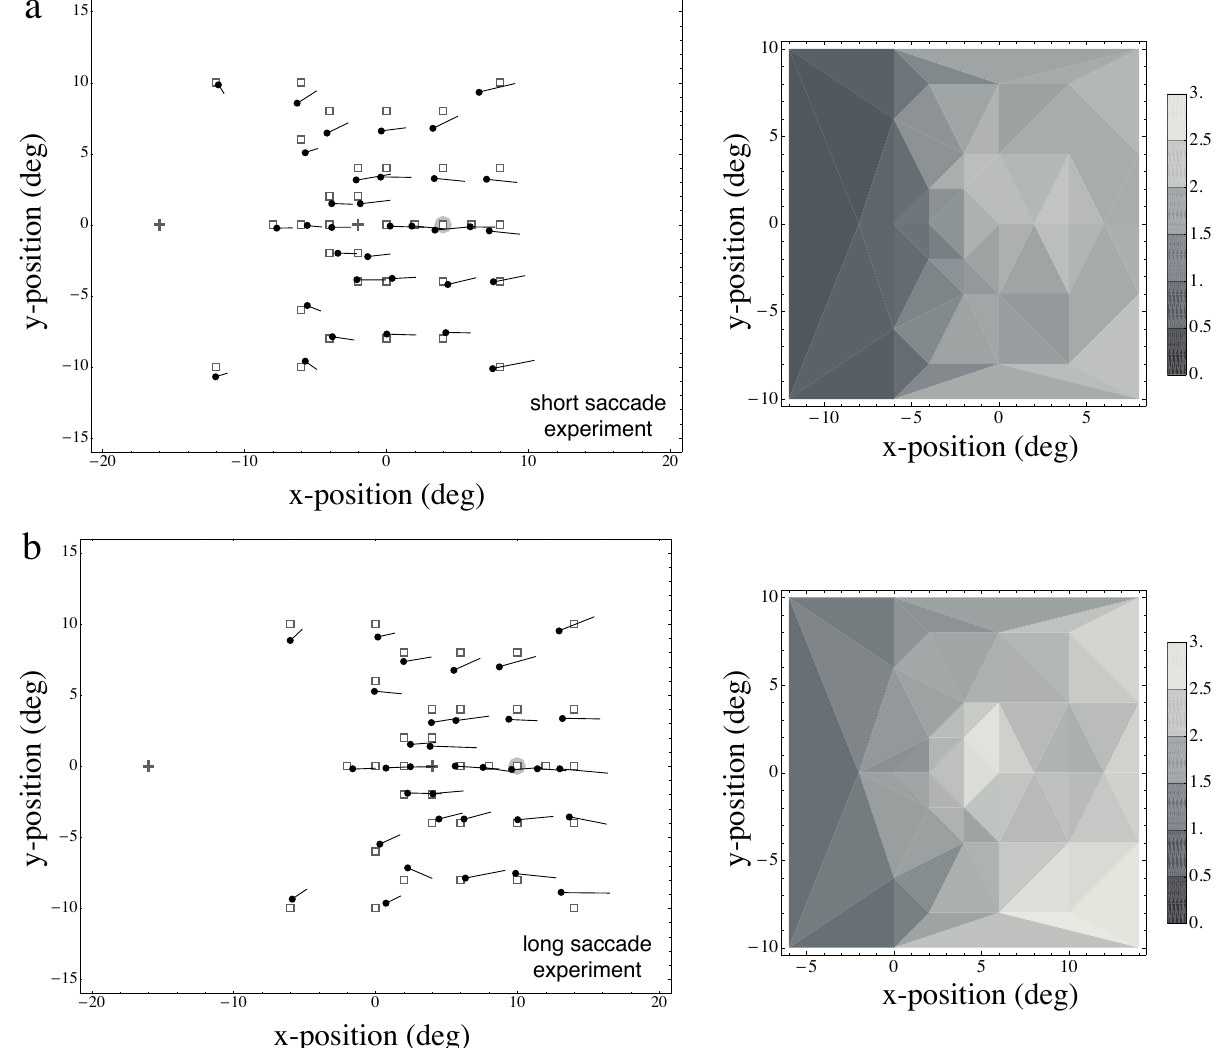
Figure 7 . a: Saccadic adaptation field for the 14 deg adapted saccade. b: Saccadic adaptation field for the 20 deg adapted saccade. Crosses indicate FP and T1 while the bright circle indicates T2. Open Squares are testing positions. Black disks represent saccade endpoints in the pre-adaptation phase. The lines point towards the saccade endpoints of the corresponding eye movements in the post-adaptation phase. Brightness in the heat maps represents amount of adaptation at a particular testing